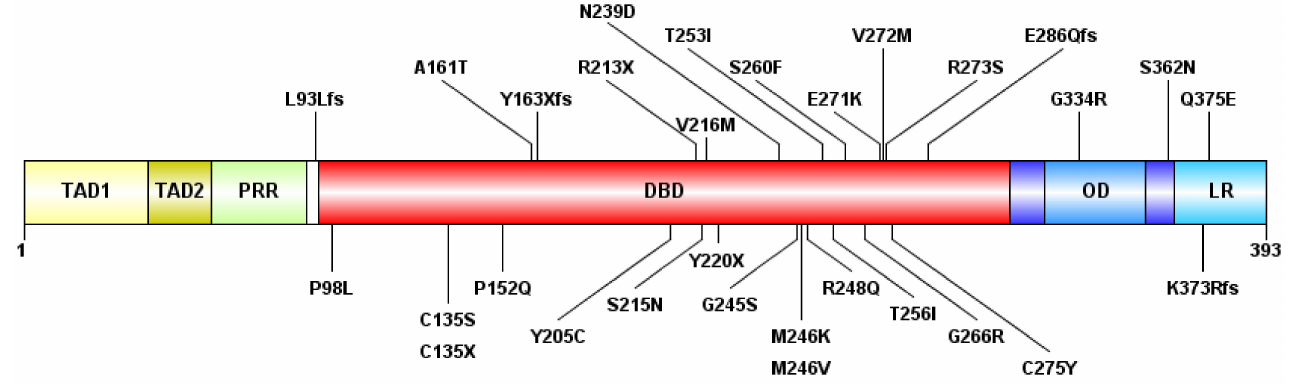
Figure 1. The schematic representation of the p53 protein structure and the detected mutations.